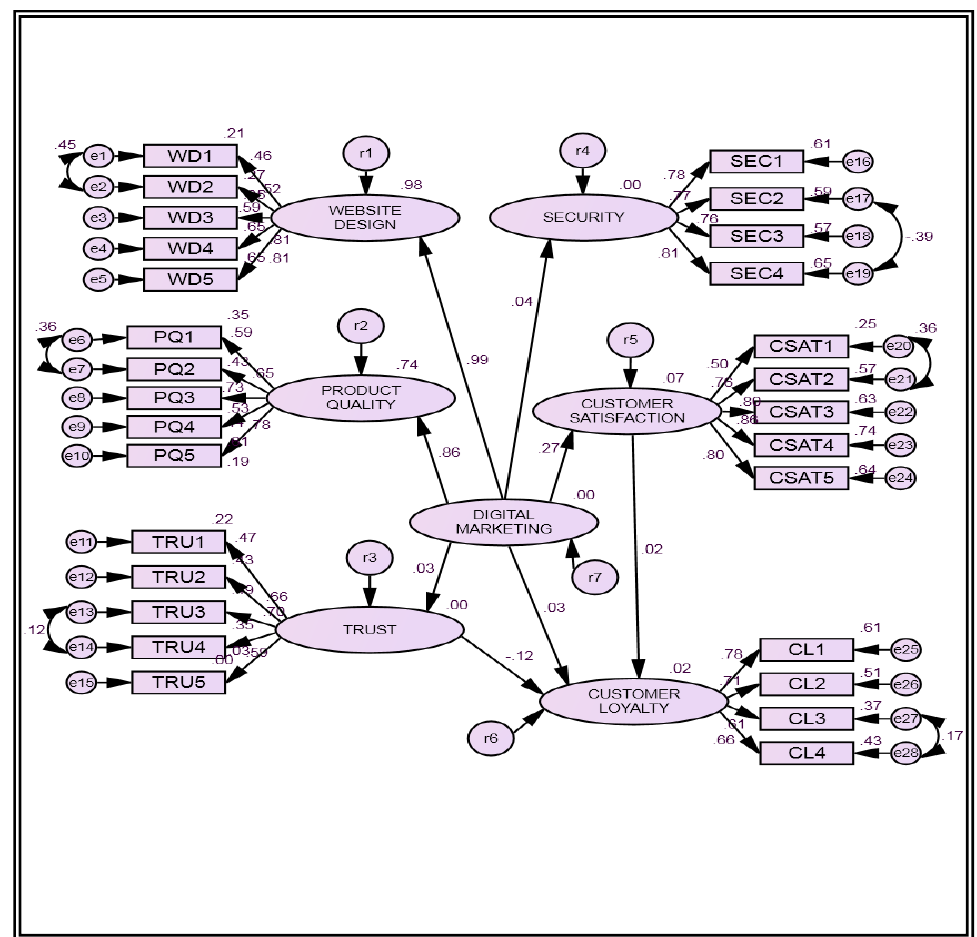
Figure 2: Structural Equation Modeling (Source: Authors‟